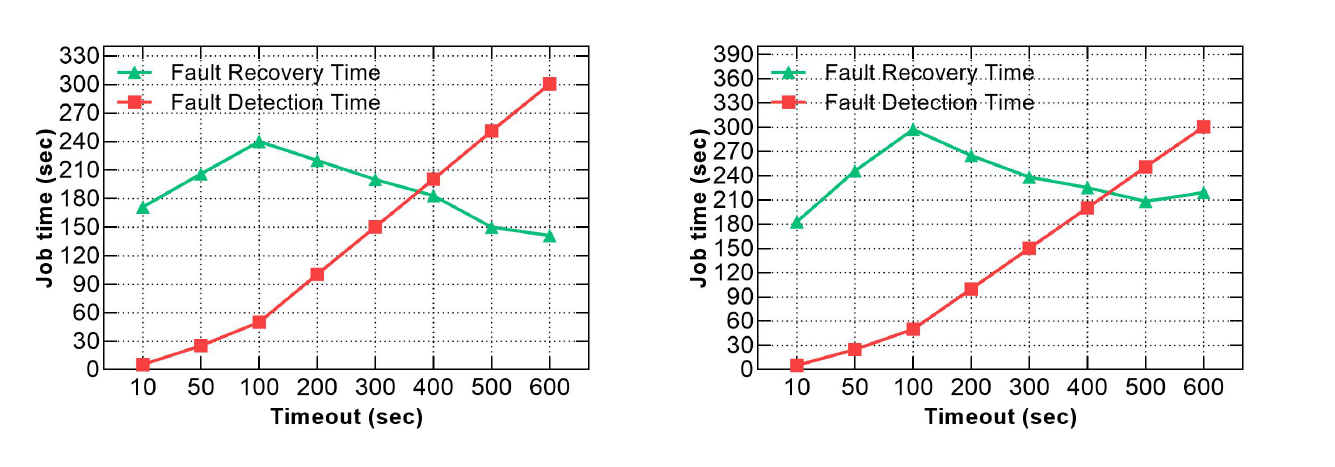
Figure 9. Comparison between fault detection and recovery times for node and service fail-stop using various timeout values.